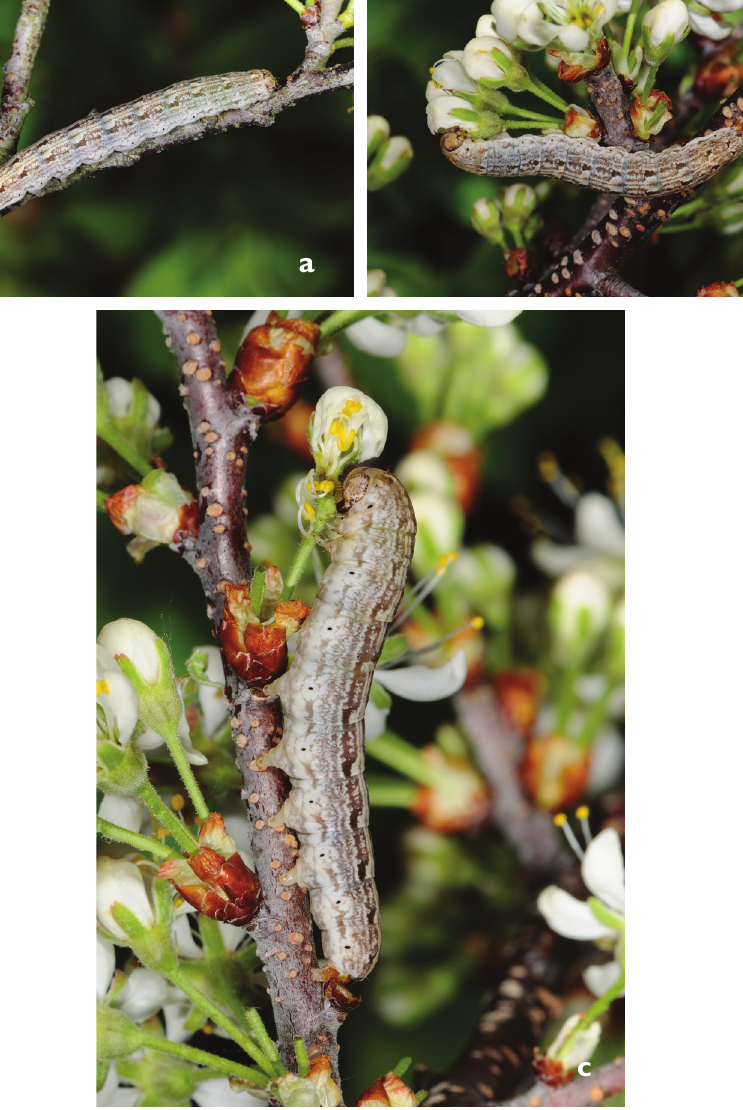
Figures 7. Larvae of Sympistis riparia . Dartmouth, MA, 2013 (M. Nelson). Holotype. (Fig. 16a, b). New York: E.N.Y. 7.17.00; Collection BrklynMus; Acc. 17,151; ♂ Gen. #1203 F.H.B. 17 July 1935; HOLOTYPE Abagrotis crumbi benja- mini J.G. Franclemont. Slide labels [Paratypes]: (Fig. 22a, b) USNM 36838 ♂ ; ♂ Gen. #1202 Lampra crum- bi n. sp. var. E.N.Y. A.C. Weeks 7.17.00 Coll. Brklyn Mus. F.H.B. 17 July 1935. Para- types (2 of 5 ♂ , 3 of 3 ♀ designated by Franclemont): New York: East New York (2 ♂ , 1 ♀ ). Connecticut: East River (1 ♀ ). Location uncertain: “Collection J.B. Smith” (1 ♀